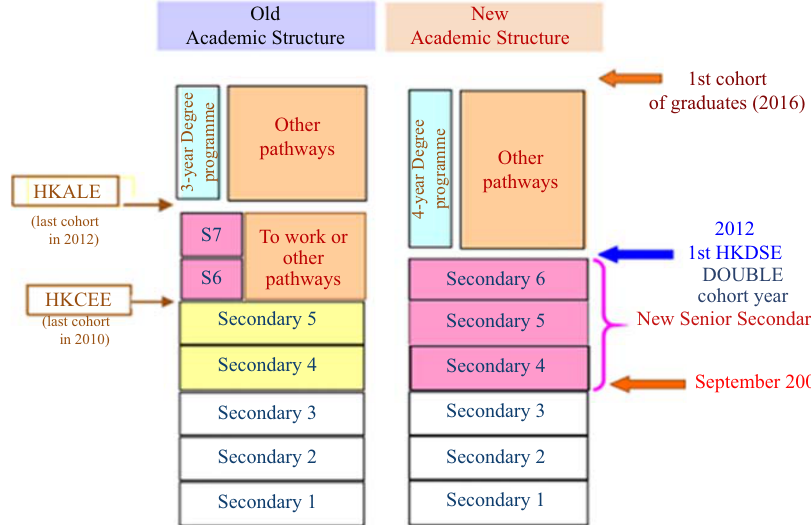
Figure 1. Comparison of old and new academic structures